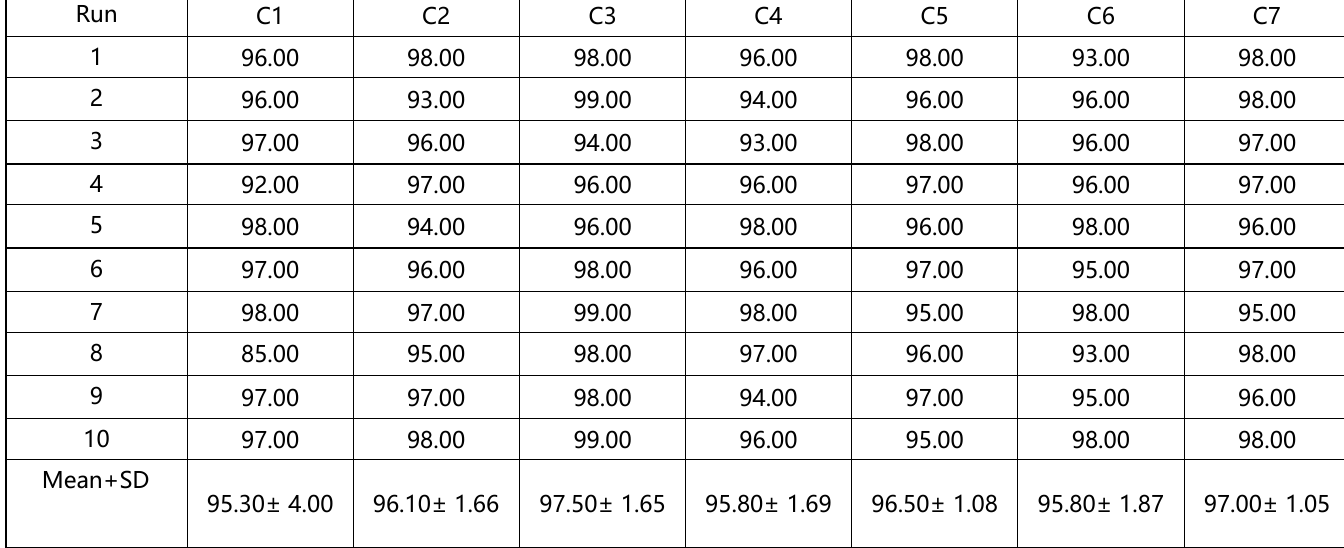
Table 1. Statistical analysis on the sensitivities of each